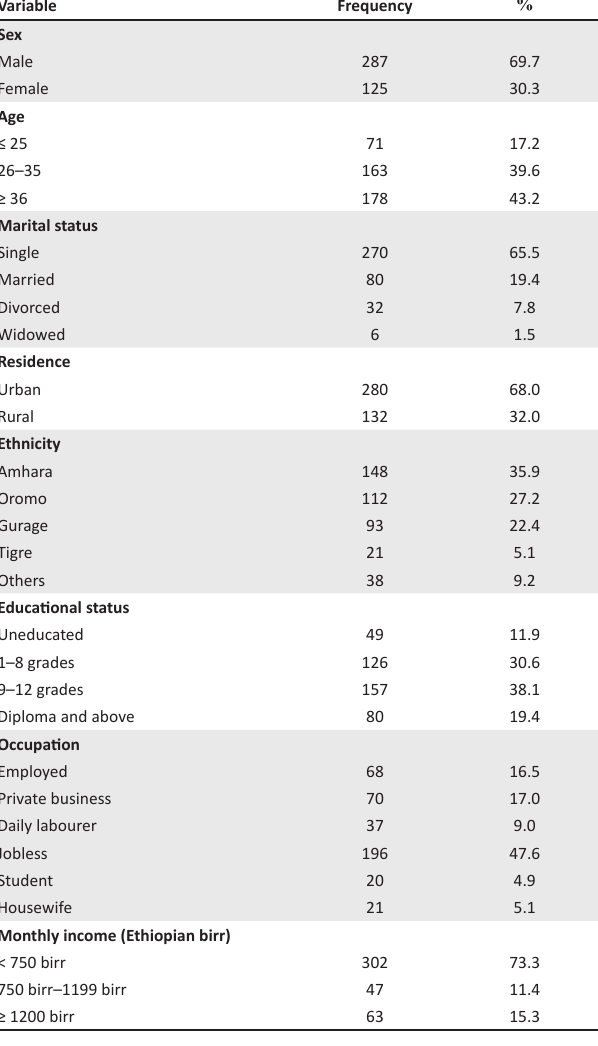
TABLE 2: Distribution of clinical and patient-related factors among schizophrenia patients at Amanuel Mental Specialized Hospital, Addis Ababa, Ethiopia, June 2014 ( n = 412).